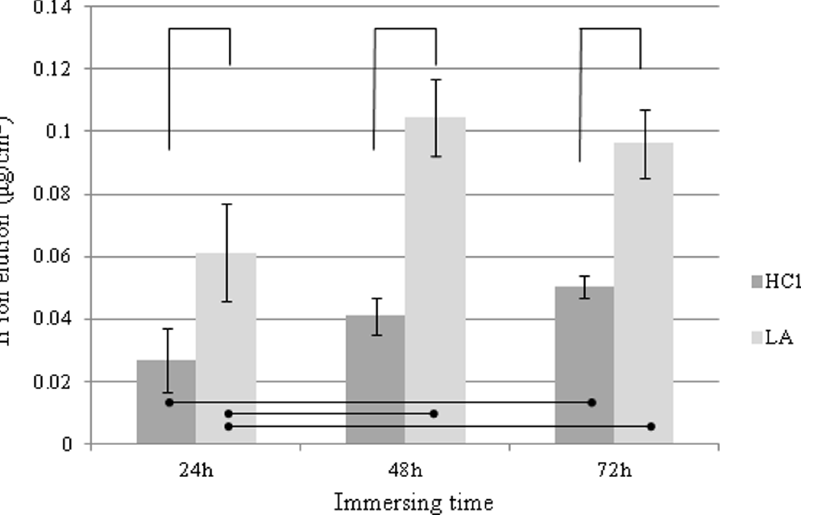
Figure 4. Effect of acid type on Ti ion elution from specimens of CP Ti immersed in SBF solutions (pH=2) for 24 to 72 h.